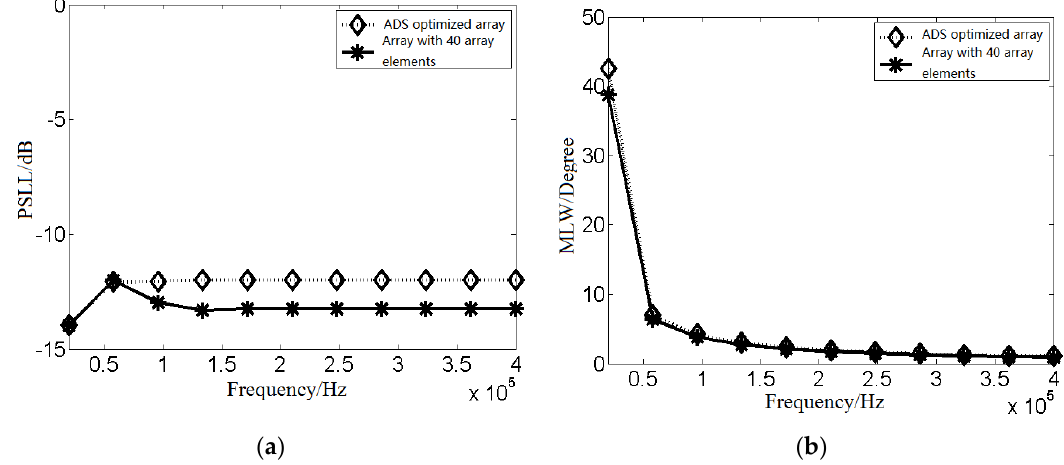
Figure 11. Receiving performances of two arrays at different frequencies. ( a ) PSLL changes at different frequencies; ( b ) main lobe width (MLW) changes at different frequencies.